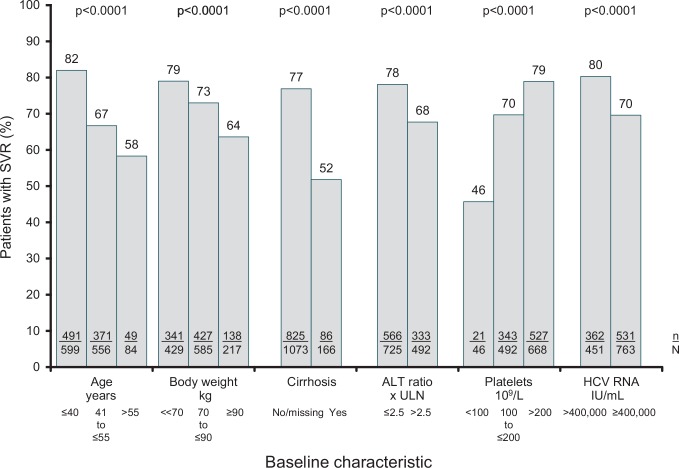
Sustained virologic response by baseline characteristic.ALT = alanine aminotransferase; ALT ratio = ALT divided by ULN for the local laboratory; ULN = upper limit of normal. P-values are based on univariate regression analysis.